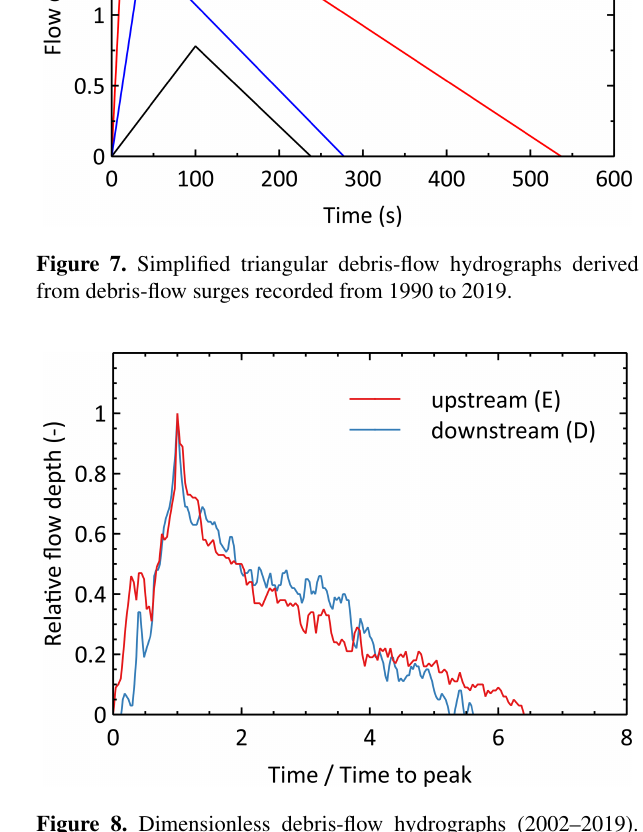
Figure 8. Dimensionless debris-flow hydrographs